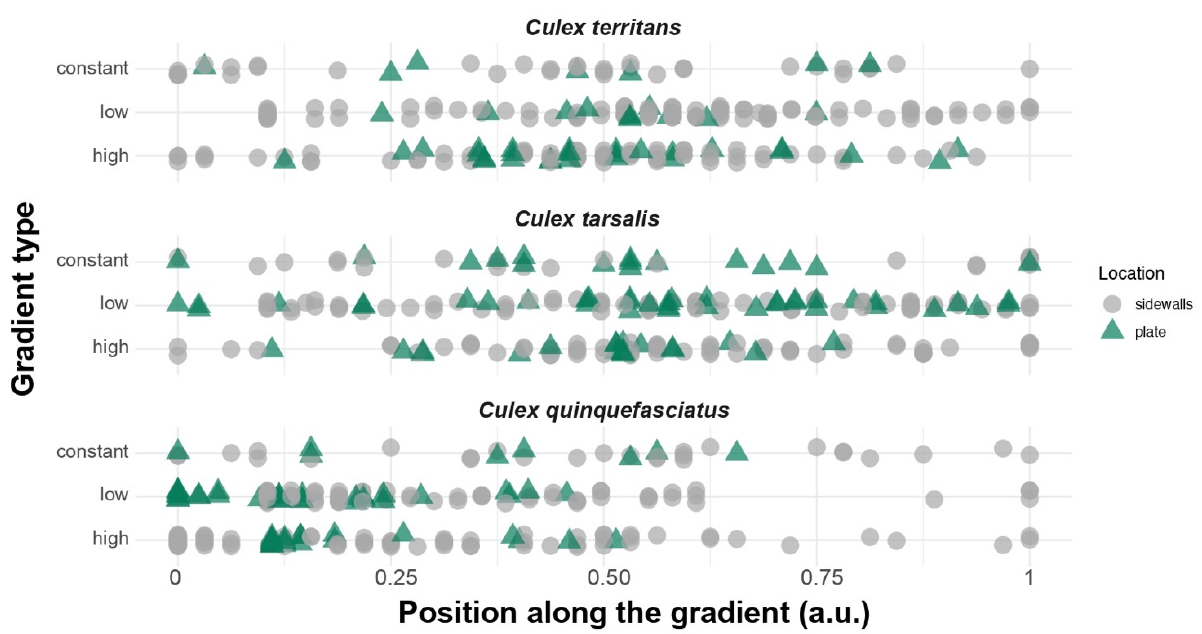
Figure 4. Proportion of mosquitoes resting on the aluminum plate (i.e., “plate”, green triangle) and on the side of the covers (i.e., “sidewalls”, grey circle) for each of the temperature gradients and mosquito species tested. Four replicates (n = 10; N = 40) have been used for the constant gradient. Ten replicates (n = 10; N = 100) per species have been used for the low and high gradients.